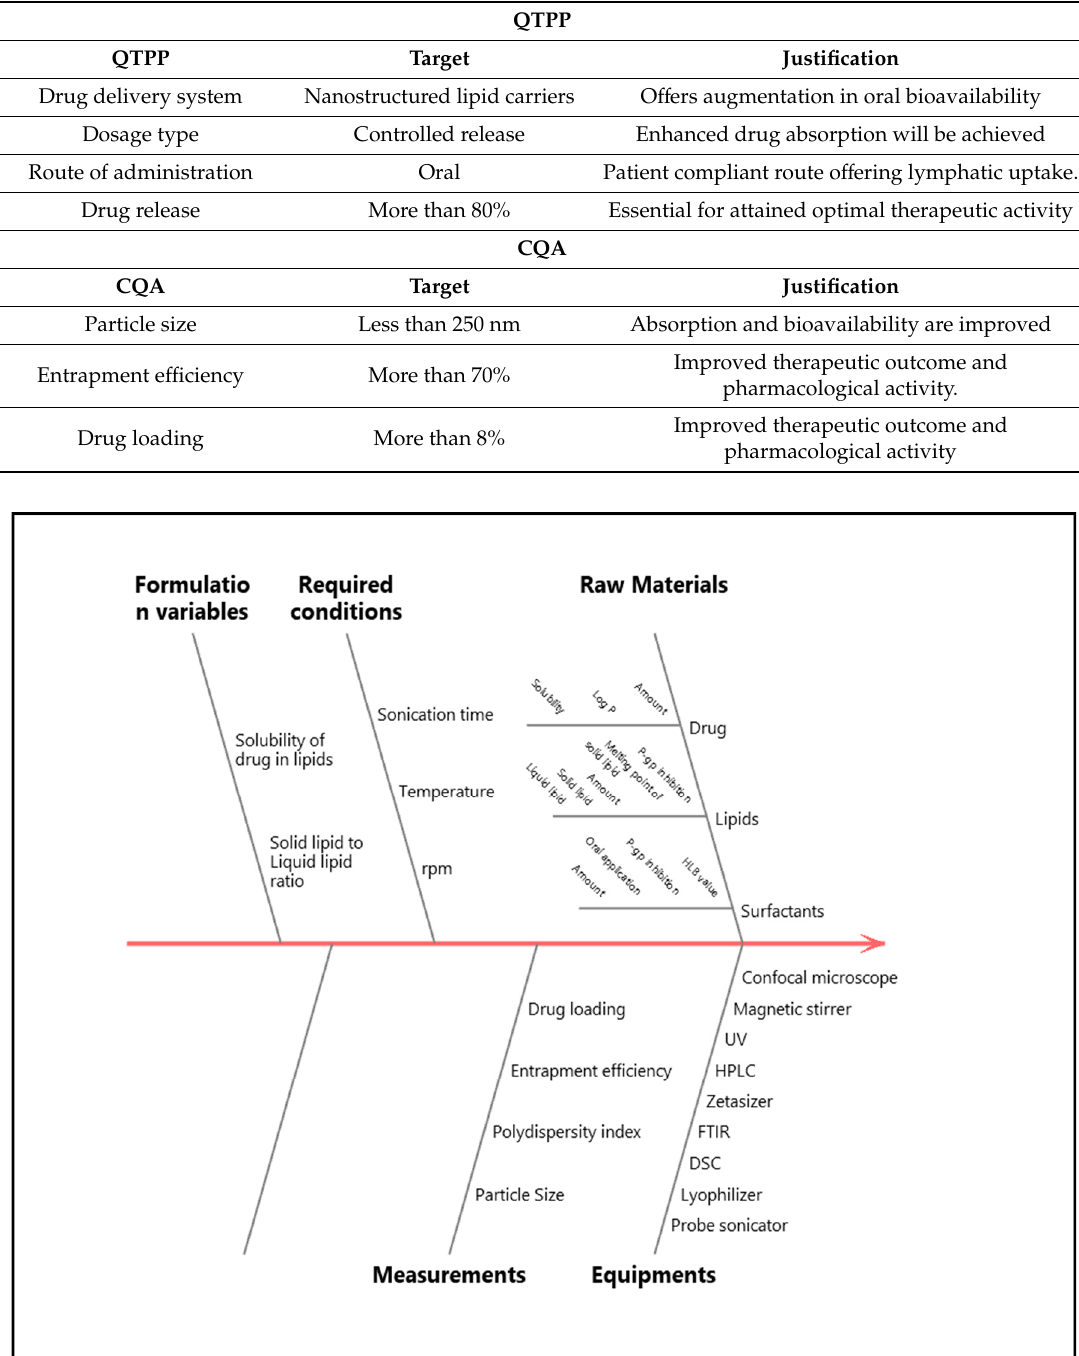
Table 1. Elements of the quality target product profile (QTPP) and critical quality attribute (CQA) for the development of the atazanavir-nanostructured lipid carrier (ATZ-NLC).